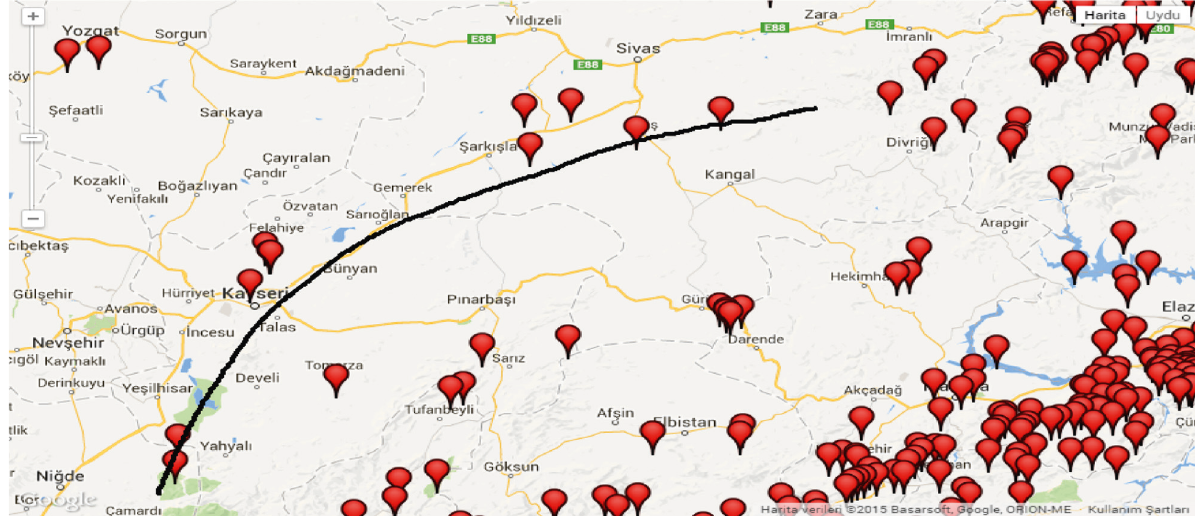
Figure 3: Earthquakes recorded on the Central Anatolian Fault Zone (CAFZ) by the strong ground motion database of Turkey